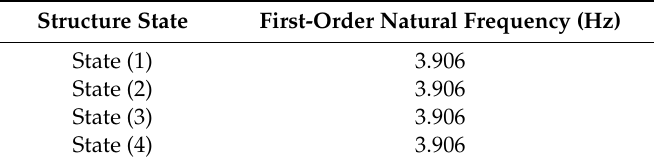
Table 3. Natural frequency of steel frame structure based on high speed camera.